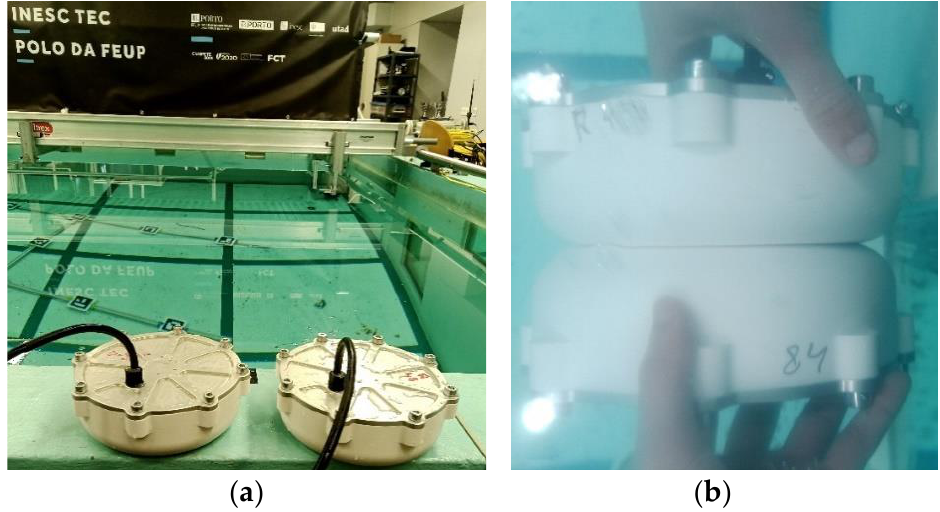
Figure 15. Power transmission efficiency over distance of the 24 V module ( a ) and the 48 V module ( b ).